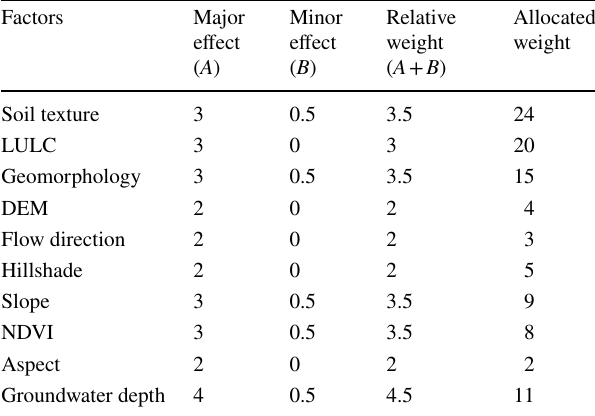
Table 6 Proposed score of each influencing